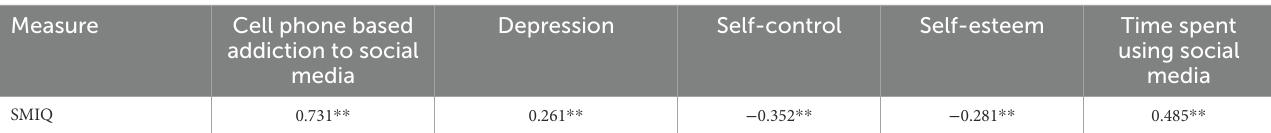
TABLE 3 Pearson correlation between SMIQ and external correlates of interests ( n =